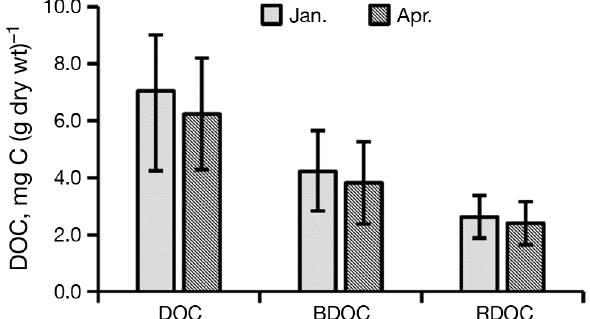
Fig. 5. Total DOC, bioavailable dissolved organic carbon (BDOC), and refractory dissolved organic carbon (RDOC) in the January and April incubations. Data are mean ± SD, n = 6